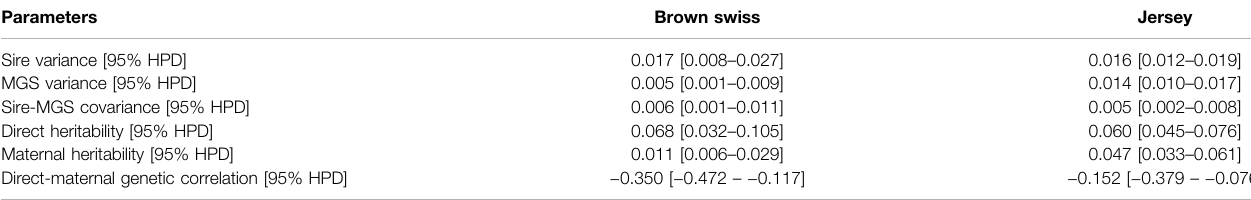
TABLE 2 | Posterior means (95% HPD) for (co)variance components, heritability, and genetic correlations for brown swiss and jersey, respectively.